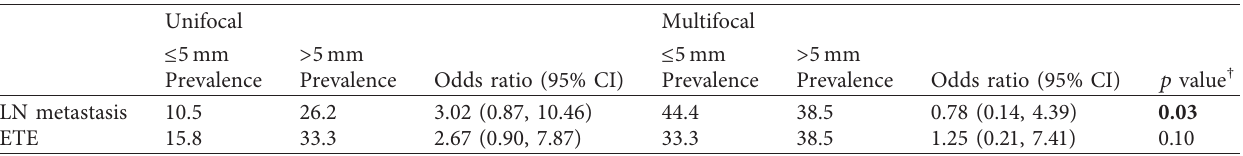
Table 6: Prevalence and odds ratios (and 95% confidence interval) of LN metastasis and ETE by tumor size ( ≤ 5 mm, > 5mm), stratified by